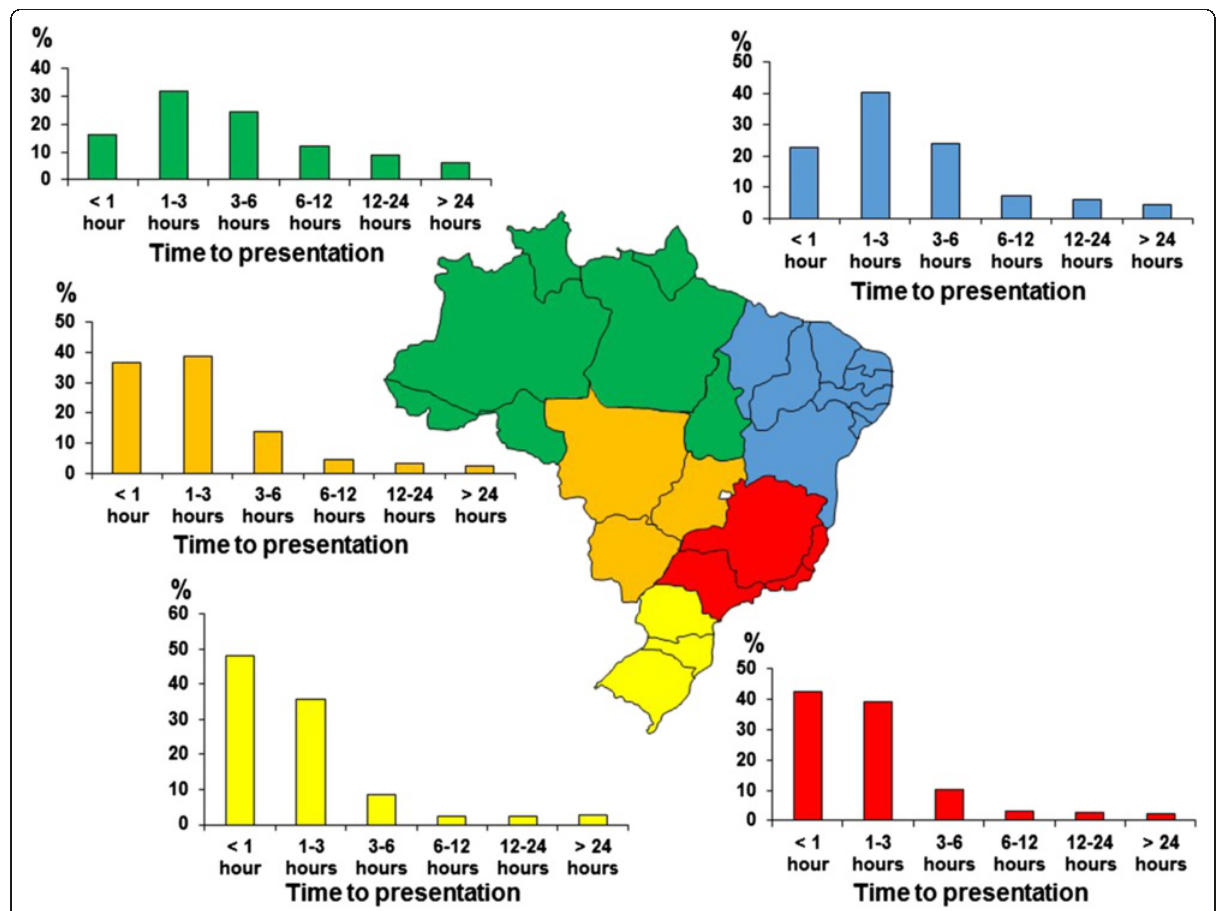
Fig. 5 Time elapsed between snakebite and medical care according to the region in